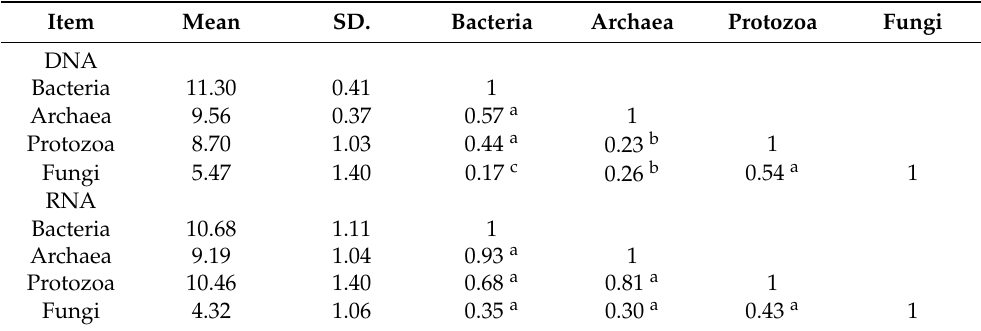
Table 2. Person correlation matrix among the four microbial groups at the population (DNA) and activity (RNA)